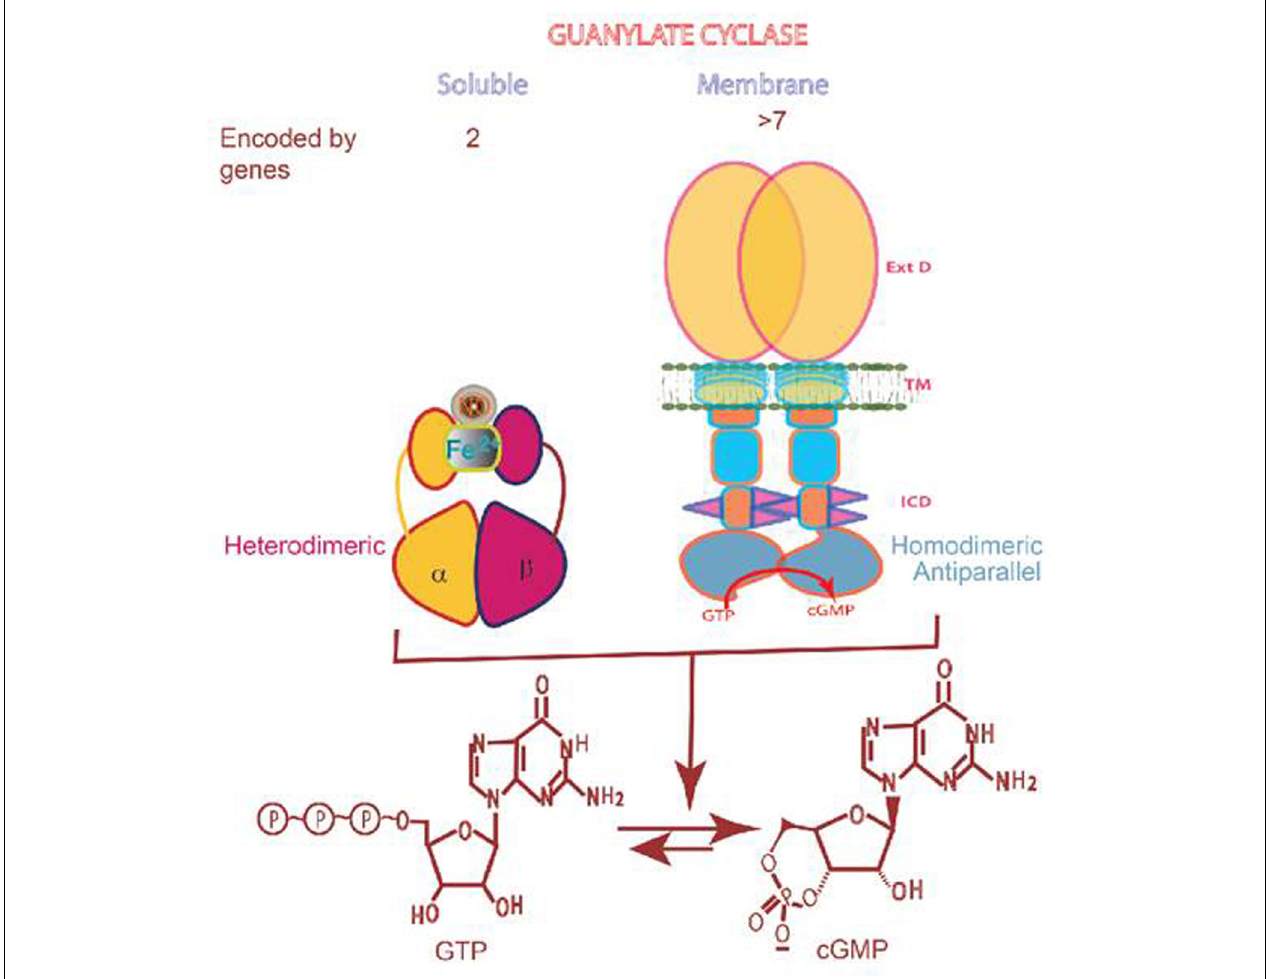
FIGURE 1 | Soluble vs membrane guanylate cyclase. Upper panel: Graphical representation of soluble and membrane guanylate cyclases. The soluble form is encoded by two genes; it is heterodimeric (subunits α and β ) and requires heme for its activity. Both monomers contribute to the catalytic center, but their orientation is unknown yet (Allerston et al., 2013). The membrane guanylate cyclase is encoded by 7 genes. It is a single transmembrane spanning protein. The extracelular domain (Ext) is located